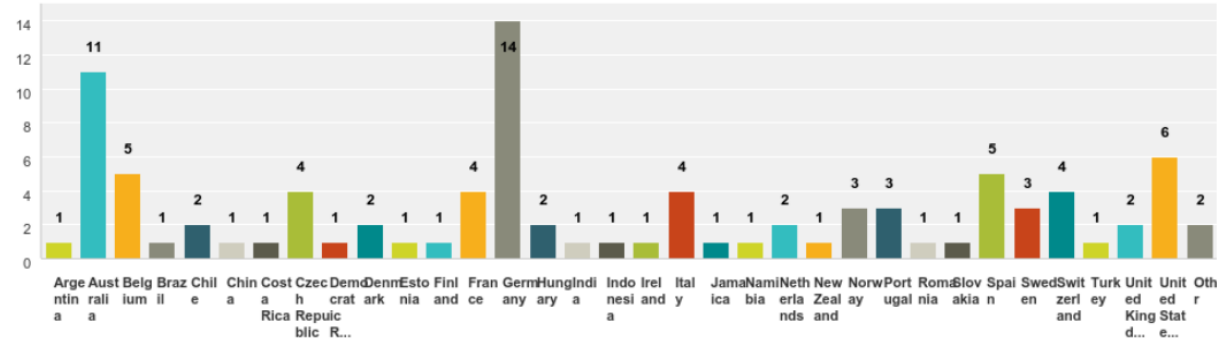
Figure 7 Countries were UAV campaigns are (planned to be) carried out.